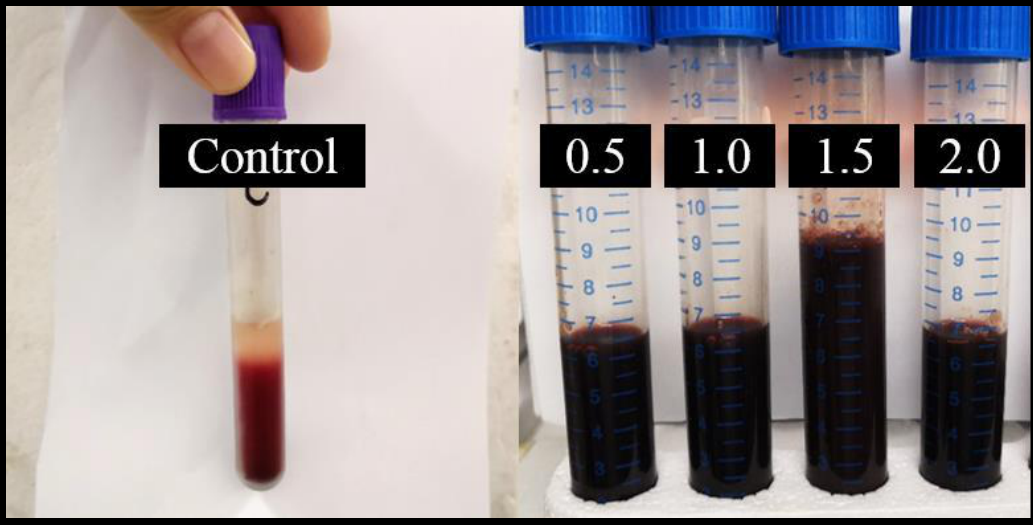
Figure 5. Di ff erences of the extracted blood samples’ color between the nitrite exposed sample and the Figure 5. Differences of the extracted blood samples’ c olor between the nitrite exposed sample and control the control group.